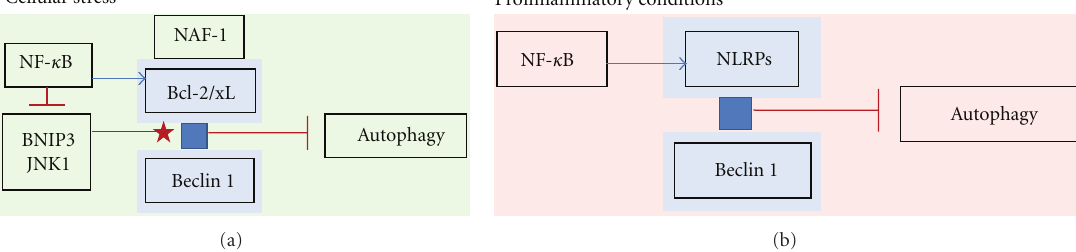
Figure 2: NF- κ B signaling controls autophagy via the Beclin 1 interactome. (a) During cellular stress, NF- κ B increases the expression of Bcl-2/xL proteins which bind via the NAF-1 to the endoplasmic reticulum and repress the function of the Beclin 1 initiation complex. On the other hand, in some circumstances, NF- κ B can inhibit the expression of BNIP3 and oppose the activity of JNK1 which normally dissociates the Beclin 1/Bcl/xL complex (star-head). (b) In proinflammatory conditions, NF- κ B signaling increases the expression of several NLRP receptors which can bind to Beclin 1 and this can inhibit